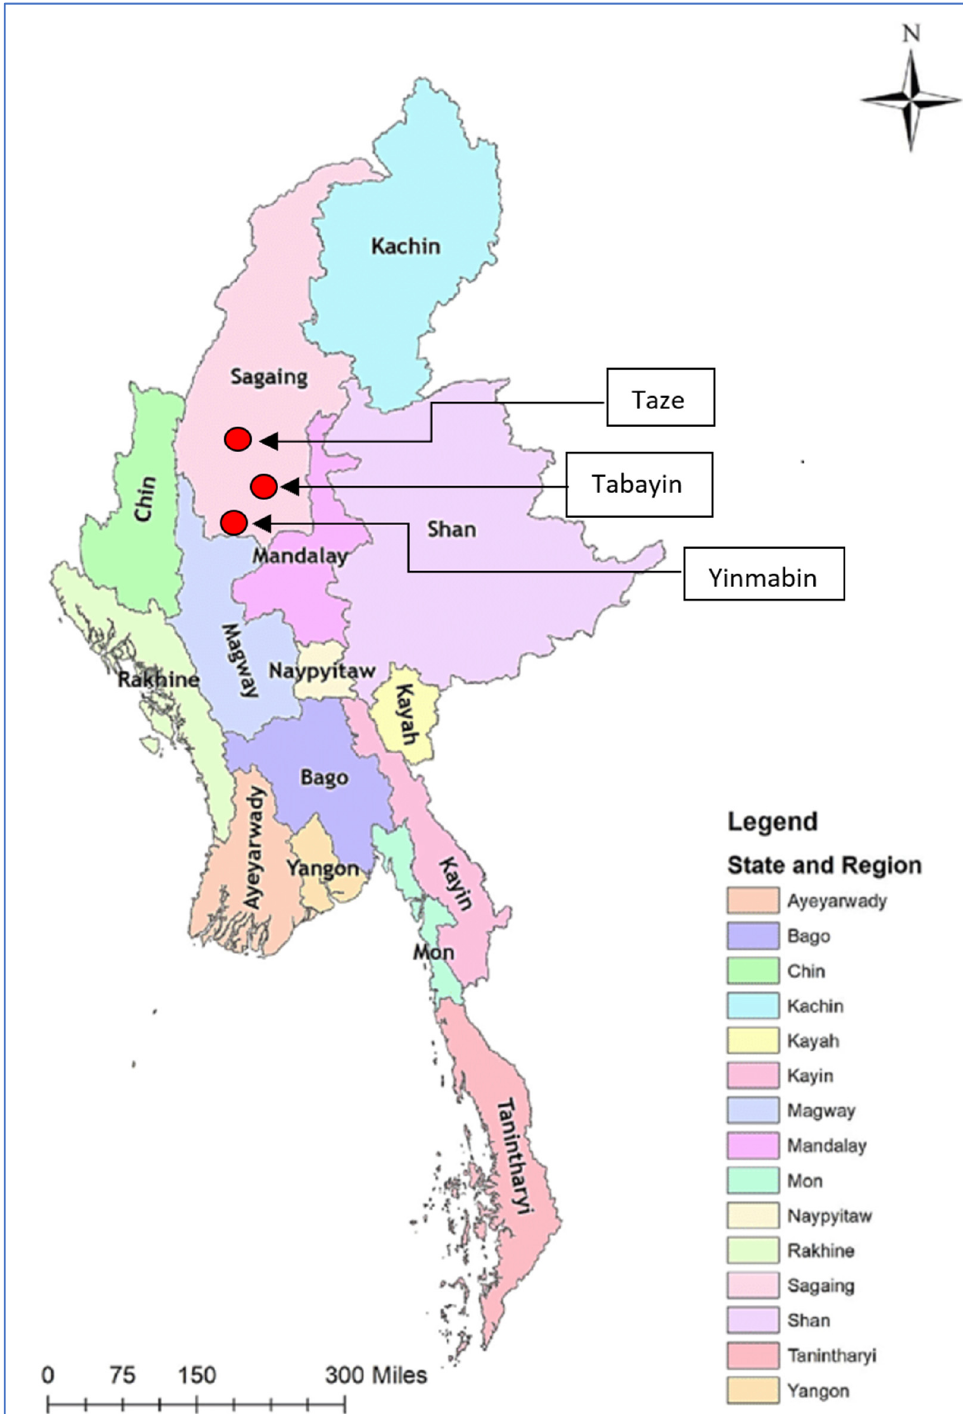
Figure 2. Map showing locations (red circles) of three townships in Sagaing region where LSD samples were collected.